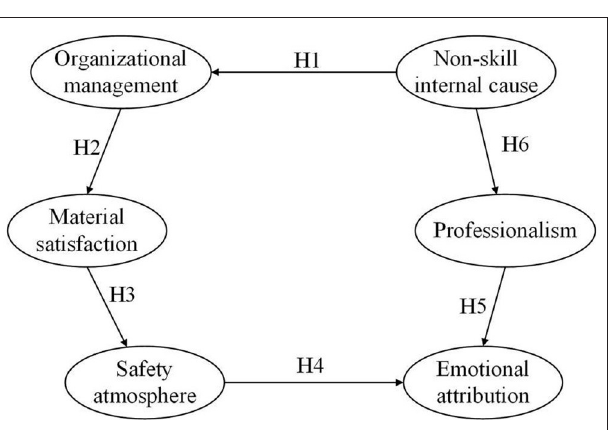
FIGURE 4 | Structural equation map of path model.